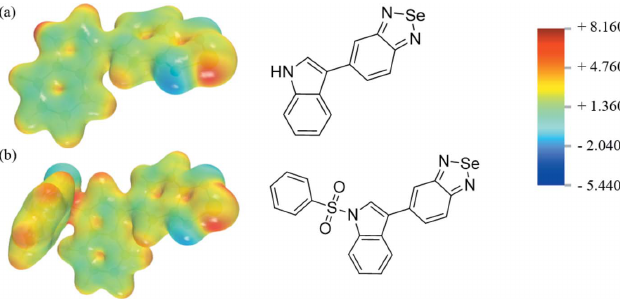
Figure 8 Computed electrostatic potential (EPS) surfaces and associated